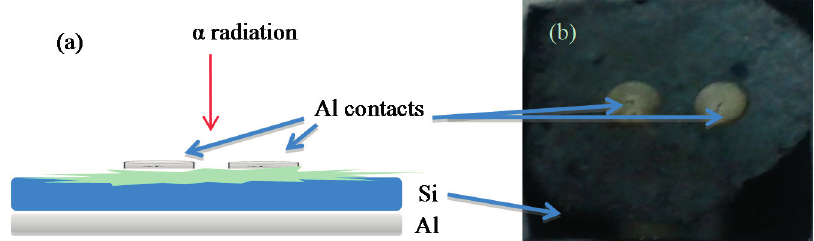
Figure 1. ( a ) Cross section view of Al/DNA/Si surface-type Schottky diodes made on the same substrate and ( b ) the actual images of the sensors.